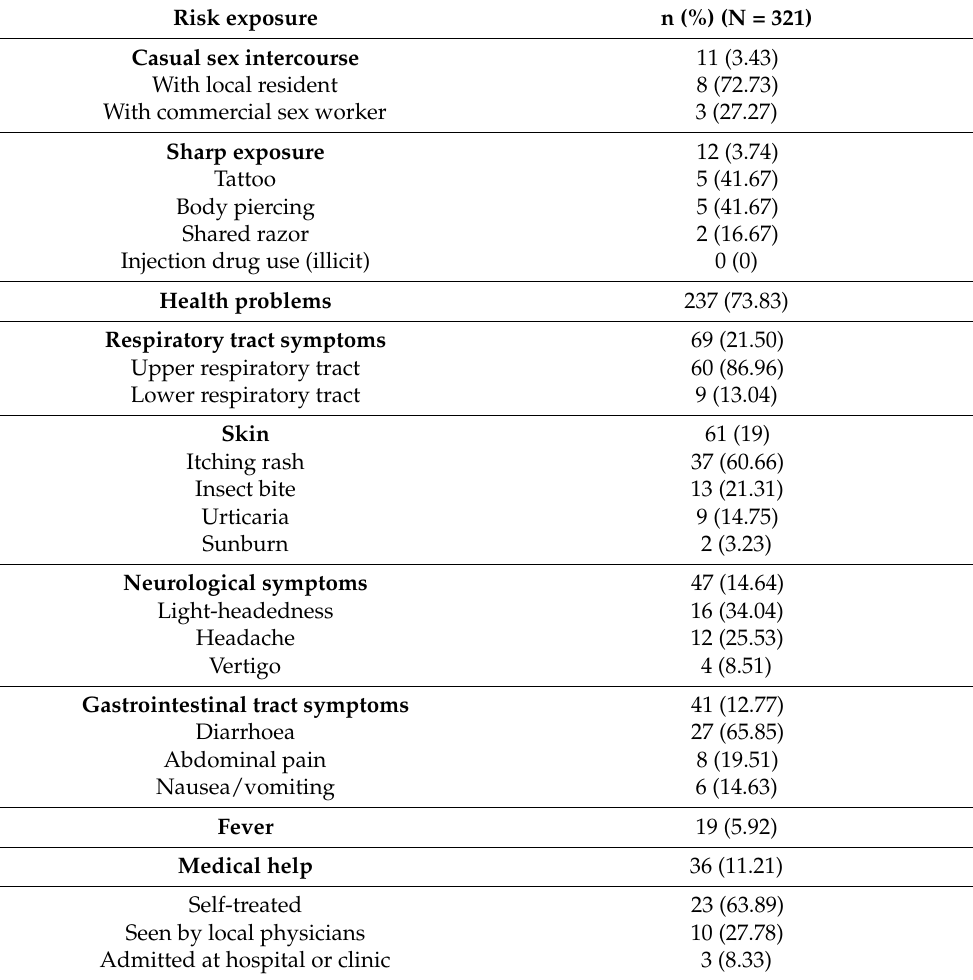
Table 4. Risk exposure, health problems, and self-care during travel among all groups of Thai travellers living with